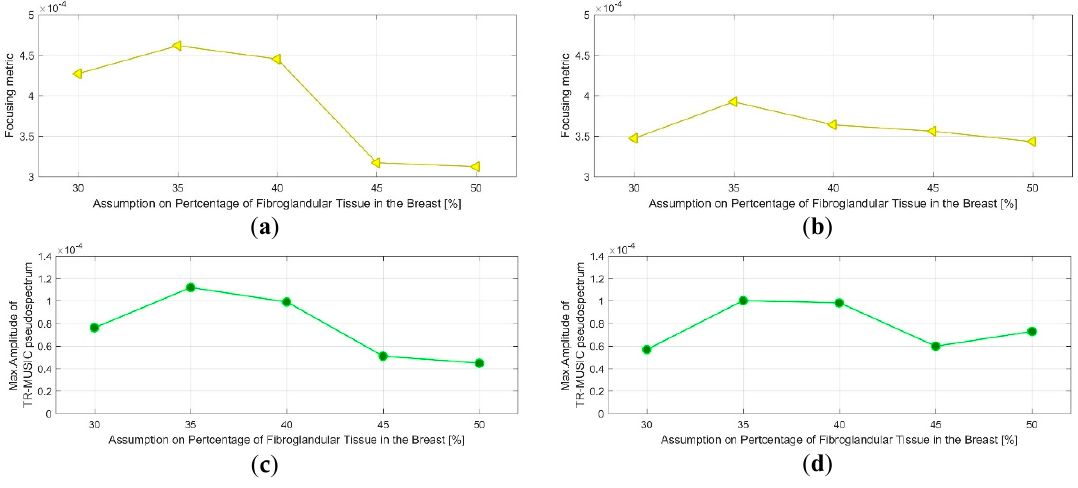
Figure 22. Breast rotational position #2: ( a ) Test Date 1, image QA metric 1; ( b ) Test Date 2, image QA metric 1; ( c ) Test Date 1, image QA metric 2; ( d ) Test Date 2, image QA metric 2.